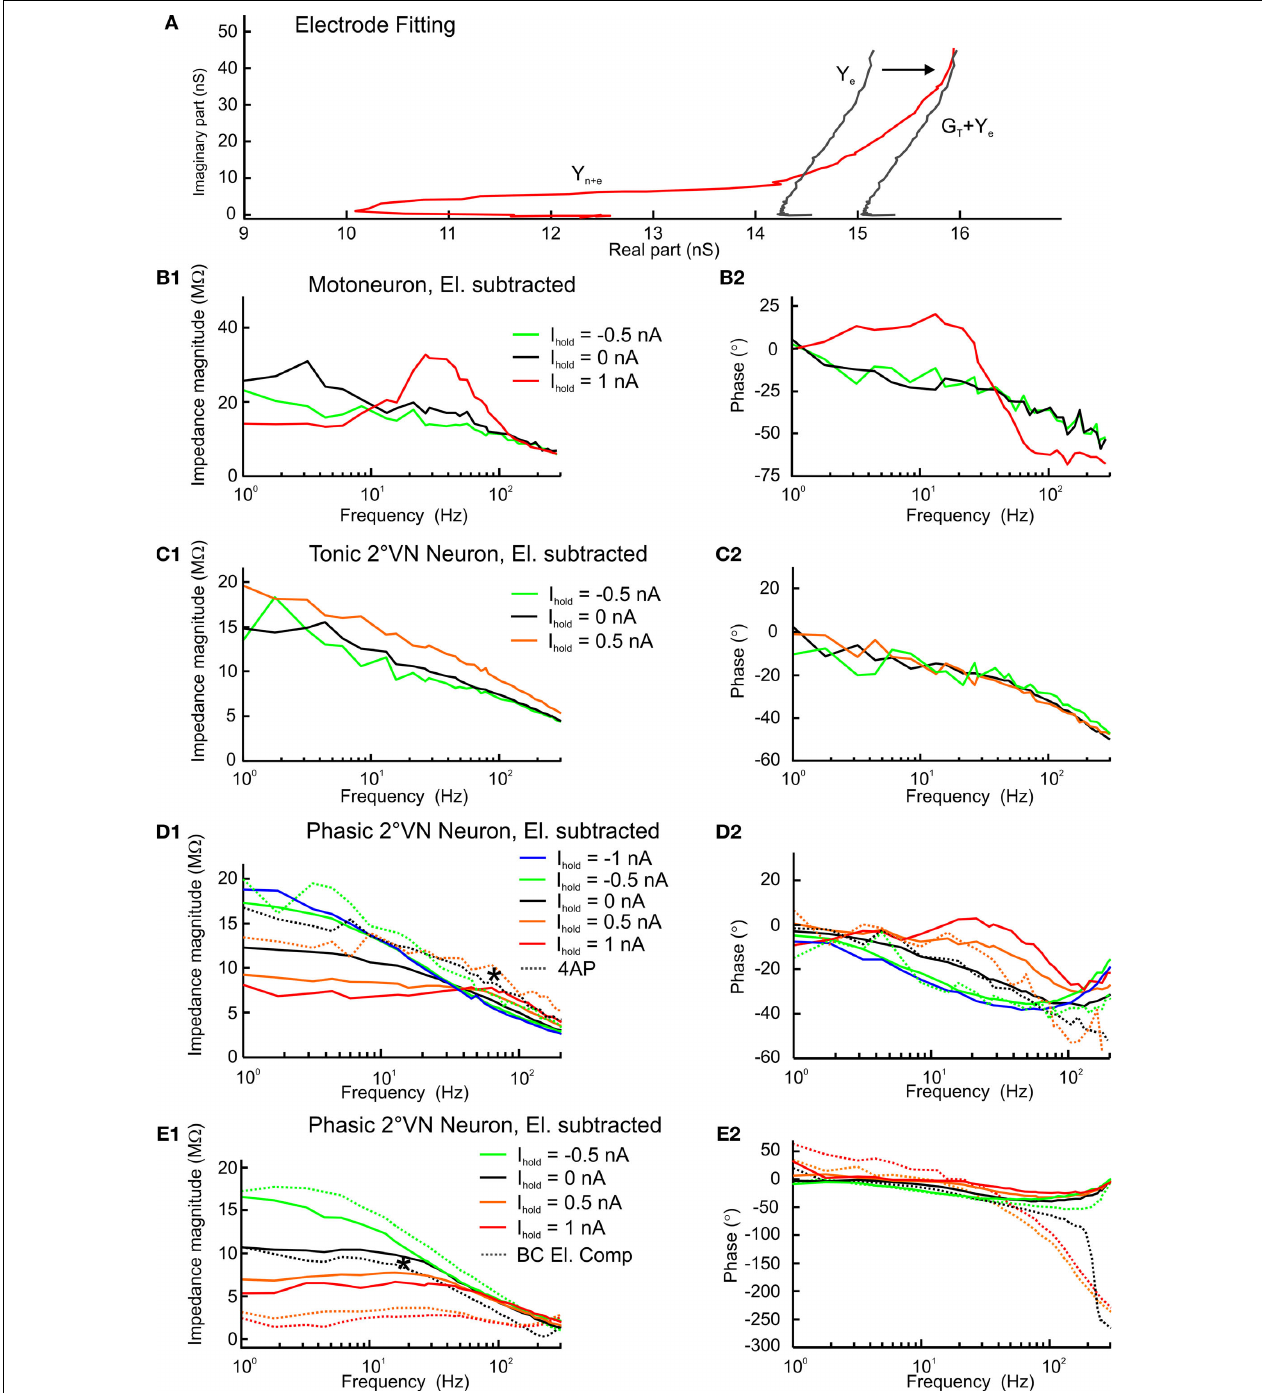
FIGURE 4 | Electrode fi tting and response dynamics of second-order phase relations of the responses at several holding currents ( I vestibular neurons (2 ° VN) and abducens motoneuron (AbMot) using (B1,B2) , a tonic (C1,C2) and two different phasic 2 ° VN (D1,D2,E1,E2) after Piece-wise Non-linear Electrode Compensation (PNEC). (A) Electrode fi tting PNEC; responses of the phasic 2 ° VN shown in (D1,D2) were measured before procedure of the responses in an AbMot at I = + 1 nA; the electrode and after bath application of 4-aminopyridine (4AP; 20 µM) [dotted lines in hold admittance Y (solid line) changed after the electrode was removed from the (D1,D2) ] with PNEC; responses of the phasic 2 ° VN shown in (E1,E2) were e + Y neuron and was shifted ( G ) in order to overlap at high frequencies with the measured after PNEC as well as during standard bridge compensation (BC) of T e properties of the electrode + neuron admittance Y ; plotted frequency the amplifi er [dotted lines in (E1,E2) ]; legends in (B1–E1) also apply n + e spectrum 0.2–980 Hz. (B1,B2–D1,D2) Impedance profi les and corresponding to (B2–E2)